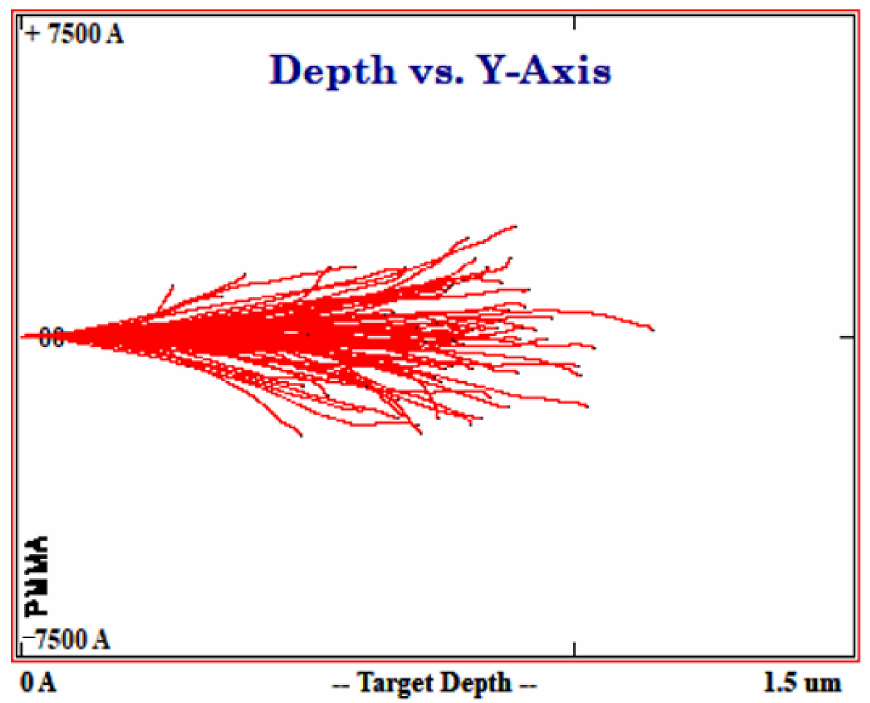
Figure 3. Penetration depth profile of Cu ions, as a function of the implant energy using the Monte Carlo SRIM